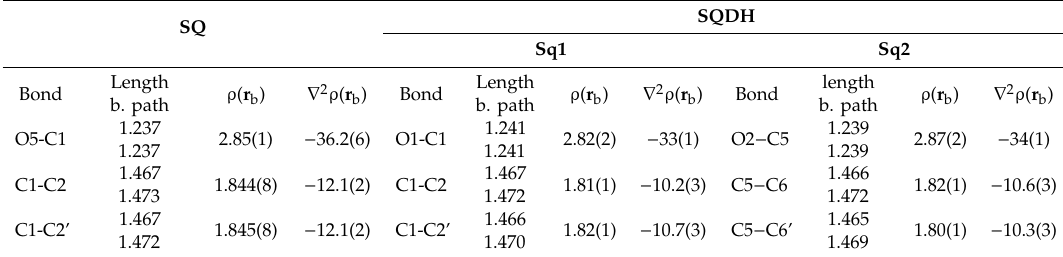
Table 6. Properties a of the charge density ρ ( r b ) (eÅ − 3 ) and the Laplacian ∇ 2 ρ ( r b ) (eÅ − 5 ) at the (3, − 1) bcps of the chemical bonds (Å) and intramolecular O ··· H contacts (Å) of the squaraine molecules in the SQ and SQDH